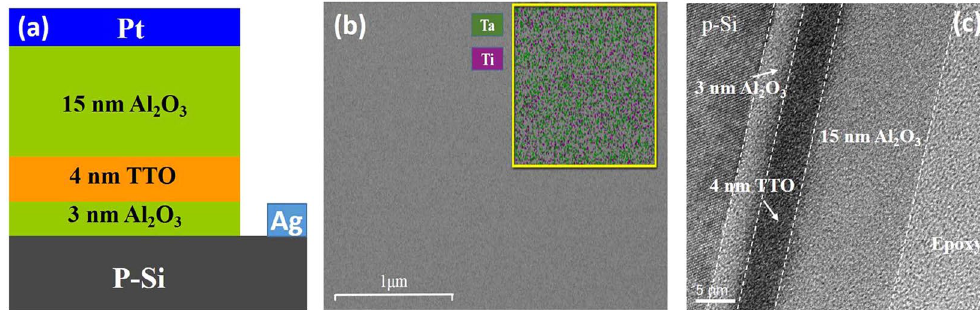
Figure 1. The schematic drawing of the structure of TTO CTM device ( a ), the surface morphology and element distribution of TTO(1:1) film ( b ), and the HRTEM cross-sectional image of TTO(1:1) CTM device ( c